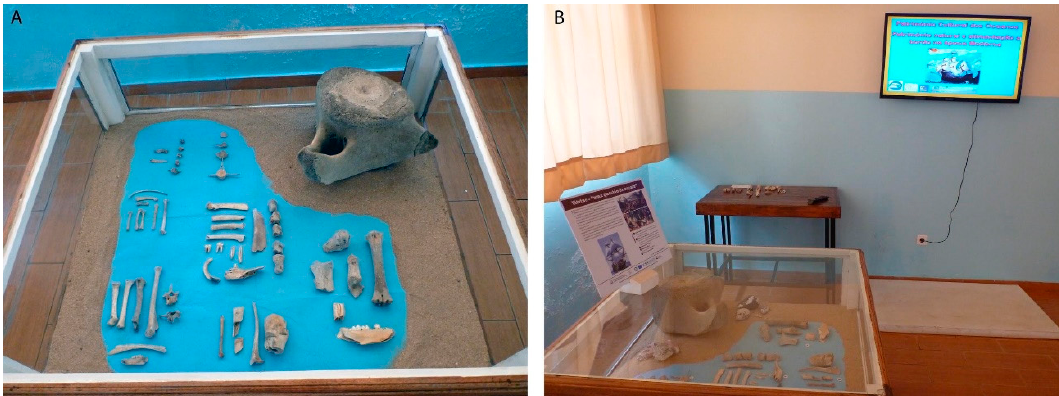
Figure 9. ( A ) Showcase “ Uma questão de escala ” display at the Museum of Archaeology (island of Santiago) including a whale vertebra, mammals and fish bones. ( B ) All showcase set with bones for identification on the table and a video about daily life on board. Photographed by Catarina Garcia 2018.